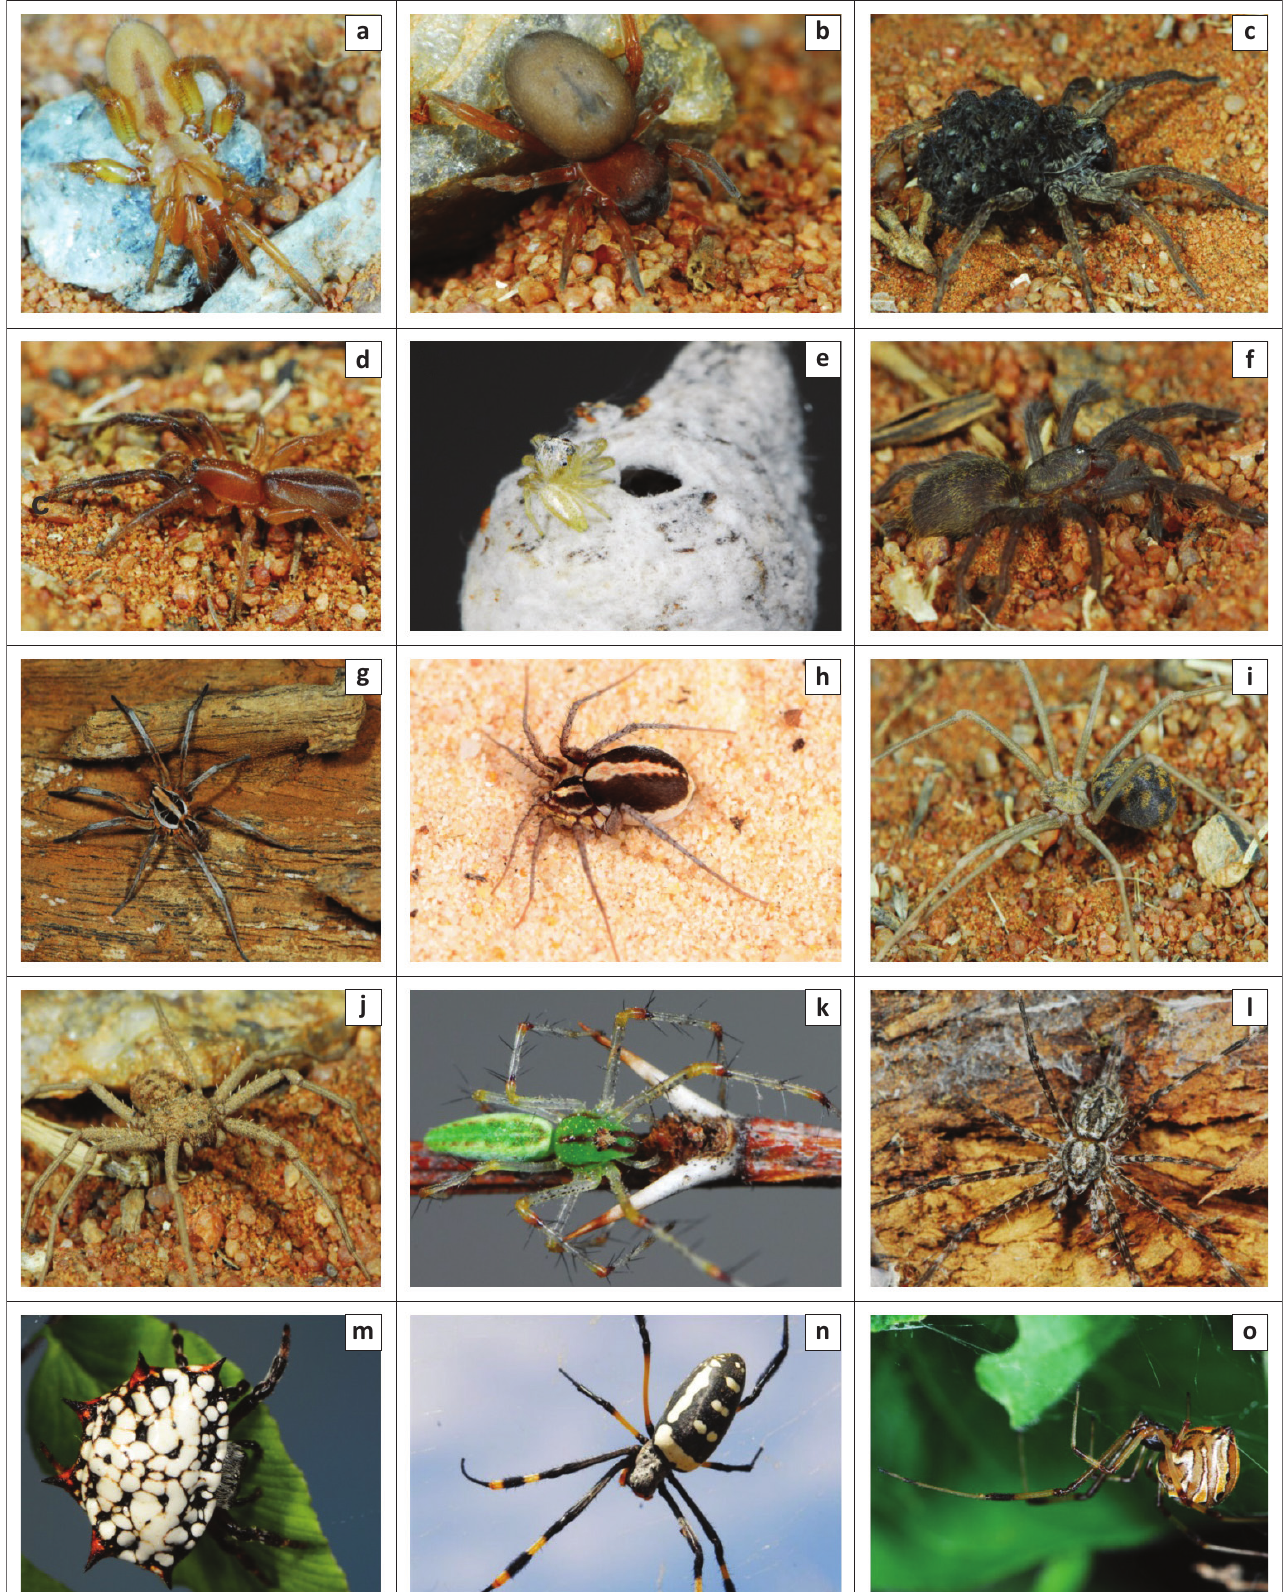
FIGURE 3: Spiders of the Tswalu Kalahari Reserve: (a) Ancylotrypa pusilla (Cyrtaucheniidae); (b) Dresserus laticeps (Eresidae); (c) Allocosa aurichelis (Lycosidae); (d) Ariadna jubata (Segestriidae); (e) Nest of immature Thyene imperialis (Salticidae); (f) Harpactirella lapidaria (Theraphosidae); (g) Hogna transvaalica (Lycosidae); (h) Ammoxenus coccineus (Ammoxenidae); (i) Loxosceles simillima (Sicariidae); (j) Sicarius testaceus (Sicariidae); (k) Peucetia viridis (Oxyopidae); (l) Hersilia sericea (Hersiliidae); (m) Isoxya mossamedensis (Araneidae); (n) Nephila senegalensis (Araneidae); and (o) Latrodectus geometricus